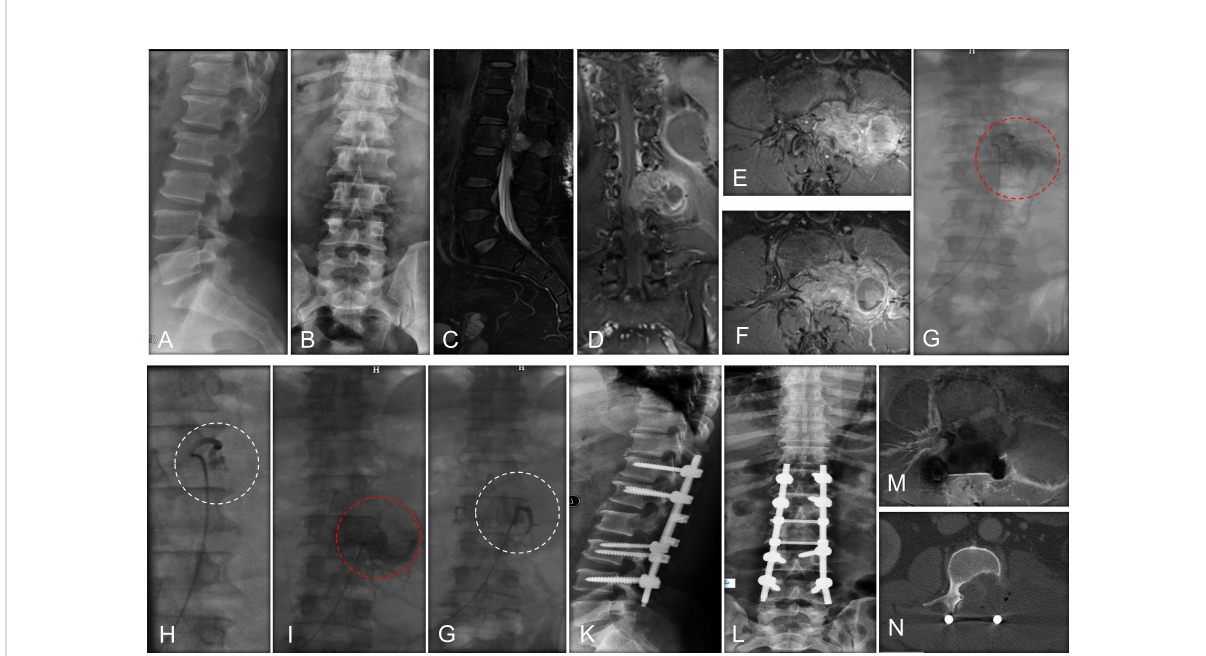
FIGURE 1 A case report of a MESCC patient who was a 50-year-old man with a histology of renal cancer and treated with preoperative embolization. (A) Perioperative lateral X-ray of MESCC; (B) Perioperative anteroposterior X-ray showed that pedicle of the vertebral arch disappeared in the left side of L2; (C) Preoperative T2-weighted sagittal MRI showing cord compression at L7; (D) Preoperative T2-weighted coronal enhanced MRI showing metastatic cancer; (E) Preoperative T2-weighted cross enhanced MRI showing metastatic cancer at L1; (F) Preoperative T2-weighted cross enhanced MRI showing metastatic cancer at L2; (G) Preoperative angiography showed extensive tumor blush from fi rst lumbar artery at left; (H) The extensive tumor blush was successfully embolized; (I) Preoperative angiography showed extensive tumor blush from the second lumbar artery at left; (J) The extensive tumor blush was successfully embolized; (K) Lateral radiograph at 1 week after surgery; (L) Anteroposterior radiograph at 1 week after surgery; (M) MRI of metastatic tumor site at 3 months after surgery, indicating no further tumor progress; (N) CT image of metastatic tumor site at 3 months after surgery. Red dotted circle indicates preoperative blush and white dotted circle indicates postoperative